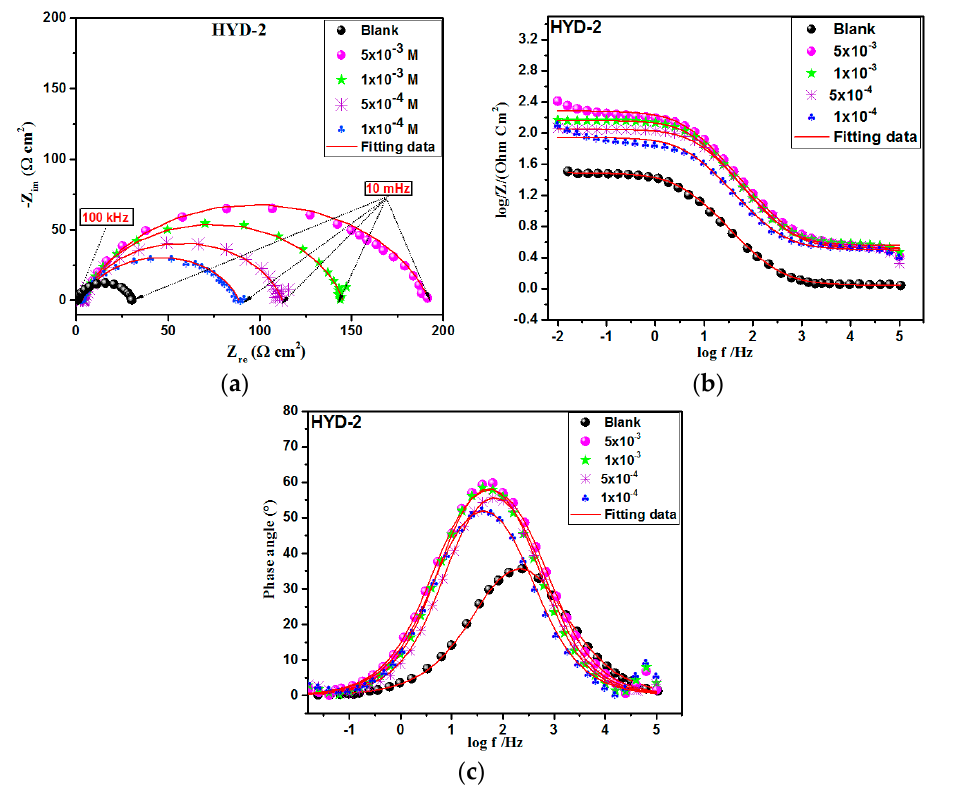
Figure 6. Nyquist ( a ), Bode ( b ), and phase angle ( c ) plots of mild steel in 1.0 M HCl with and without various concentrations of HYD-2 inhibitor.